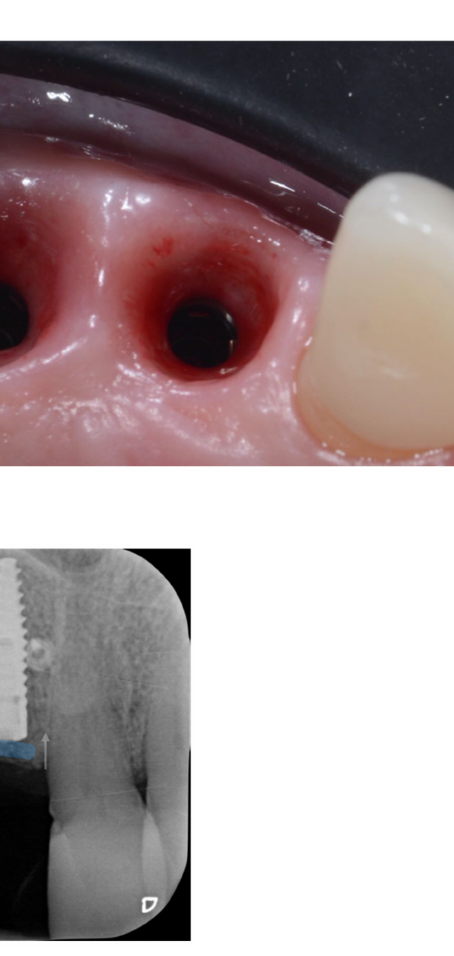
Figure 18. Progression of the case.